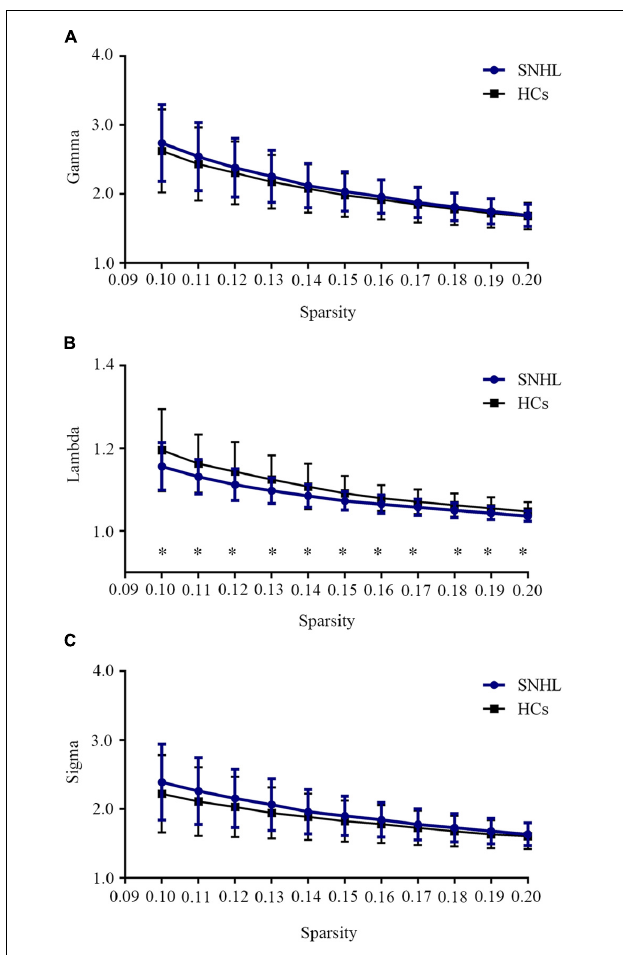
FIGURE 1 | Small-world network properties of SNHL and HCs over a defined range of sparsity (0.10–0.20). (A) Comparison of brain network Gamma values between SNHL and HCs; (B) comparison of brain network Lambda values between SNHL and HCs; (C) comparison of brain network Sigma values between SNHL and HCs. Both groups had typical small-world features, as gamma > 1, lambda ≈ 1, sigma > 1. Values of lambda in SNHL group were significantly lower than HCs. SNHL, sudden sensorineural hearing loss; HCs, healthy controls. ∗ p <